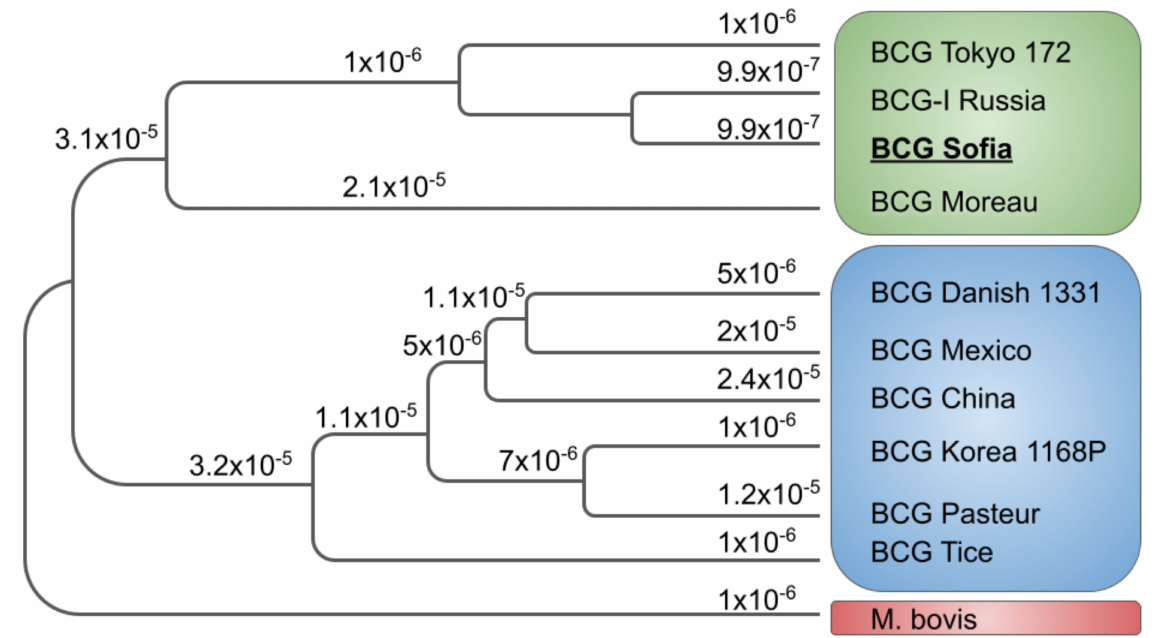
Figure 2. Randomized Axelerated Maximum Likelihood (RAxML) phylogenetic tree of 10 completed BCG genomes. The topology is rooted with M. bovis (LT708304). Over each branch is annotated the calculated nucleotide substitution rate. The “early” and the “late” groups of BCG are represented in green and blue,